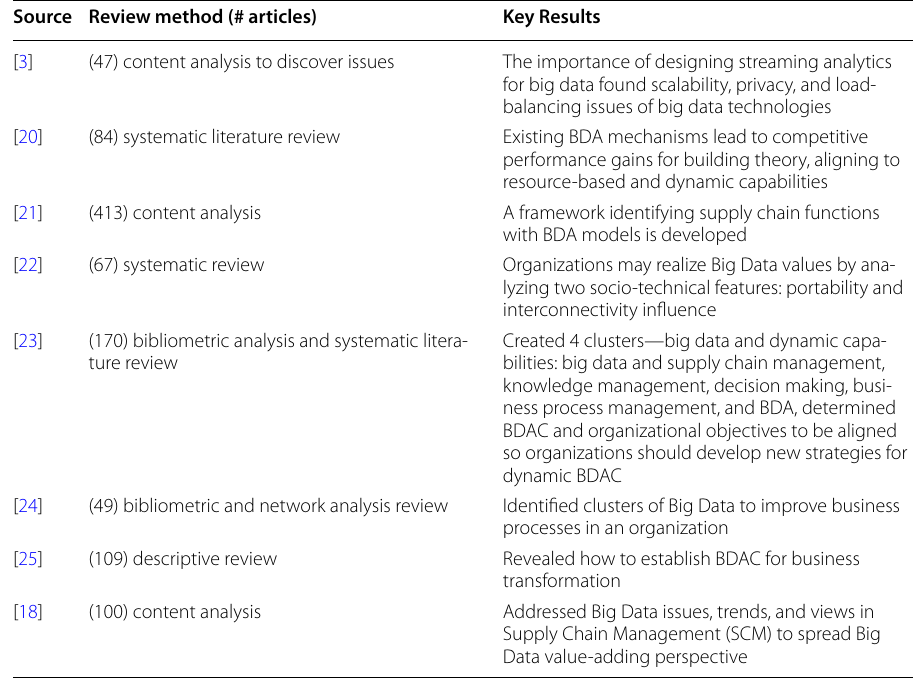
Table 1 Example studies that focus on technical or problem-solving aspects of BDA Source Review method (#